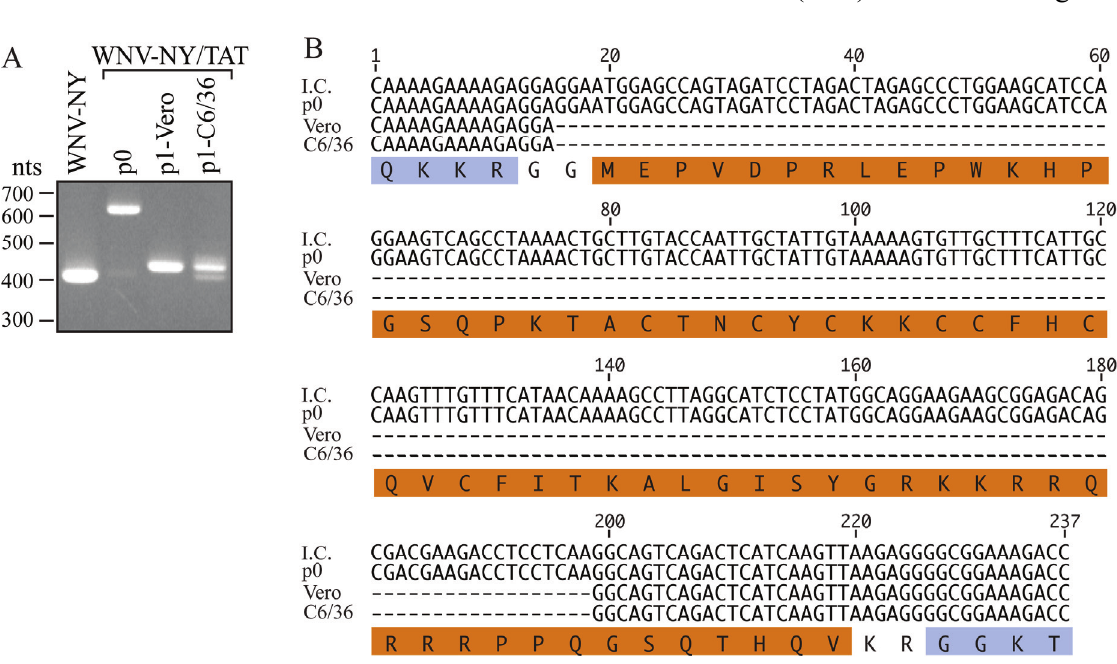
Figure 3. Passage of WNV-NY/TAT on insect cells. ( A ) RT-PCR analysis. RNA was extracted from cells transfected with WNV-NY/TAT RNA (p0) and Vero or C6/36 monolayers infected with the p0 virus (p1). The extracted RNA was used as template for RT-PCR amplification of the WNV C/CA region (WNV nts 97-500). RNA recovered